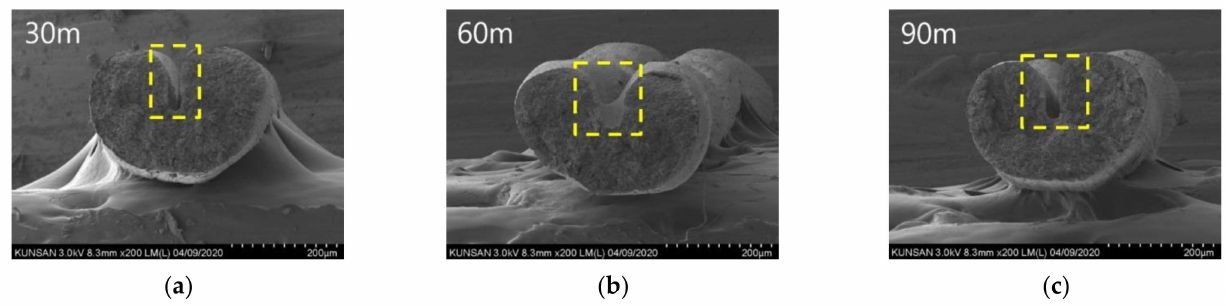
Figure 12. SEM images of case 1 ( x 1 : x 2 : x 3 : x 4 = 40:60:120:200). ( a ) Specimen 30 m; ( b ) Specimen 60 m; ( c ) Specimen 90 m.